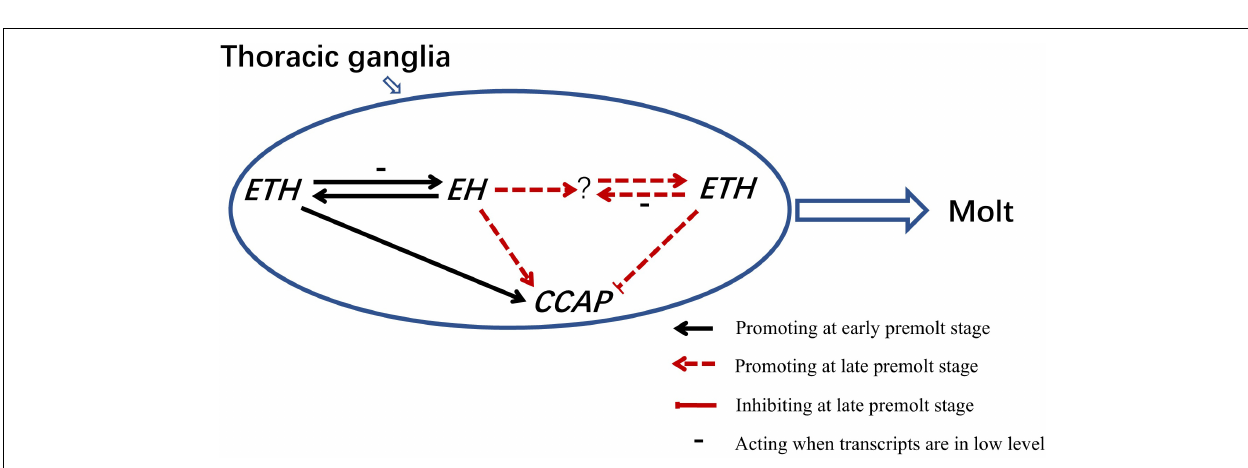
FIGURE 6 | Relative transcript levels of ETH (A) , EH (B) , and CCAP (C) in thoracic ganglia of dsGFP and co-injected crabs at D2 stage were measured. These data represented the mean ± SD. For each sample, three independent pools of five individuals were measured in technical triplicate using real-time quantitative PCR (qRT-PCR). Statistically significant differences between the measurements were found via a t -test with Welch’s correction and are indicated by asterisks (* P < 0.05; *** P < 0.001).